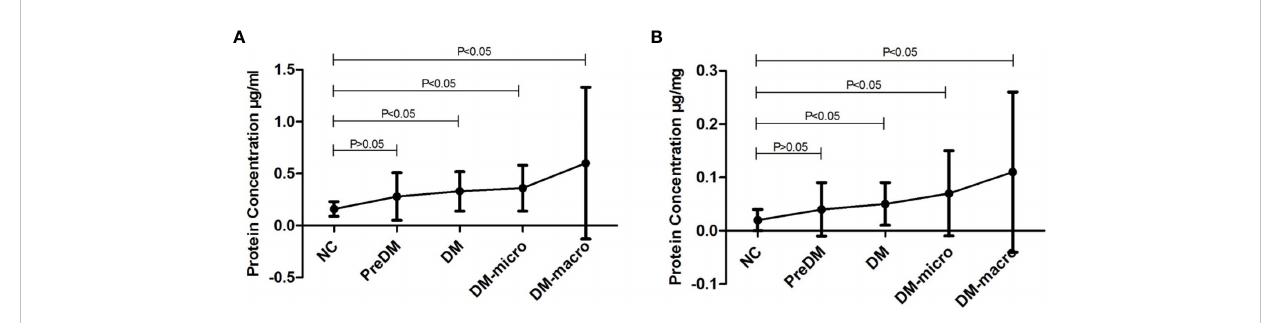
FIGURE 4 Protein concentration of uEVs in normal controls and diabetes. (A) . Protein concentration of uEVs in normal controls and diabetes (Mean±SD). (B) . Protein concentration of uEVs in normal controls and diabetes (Mean±SD) adjusted by